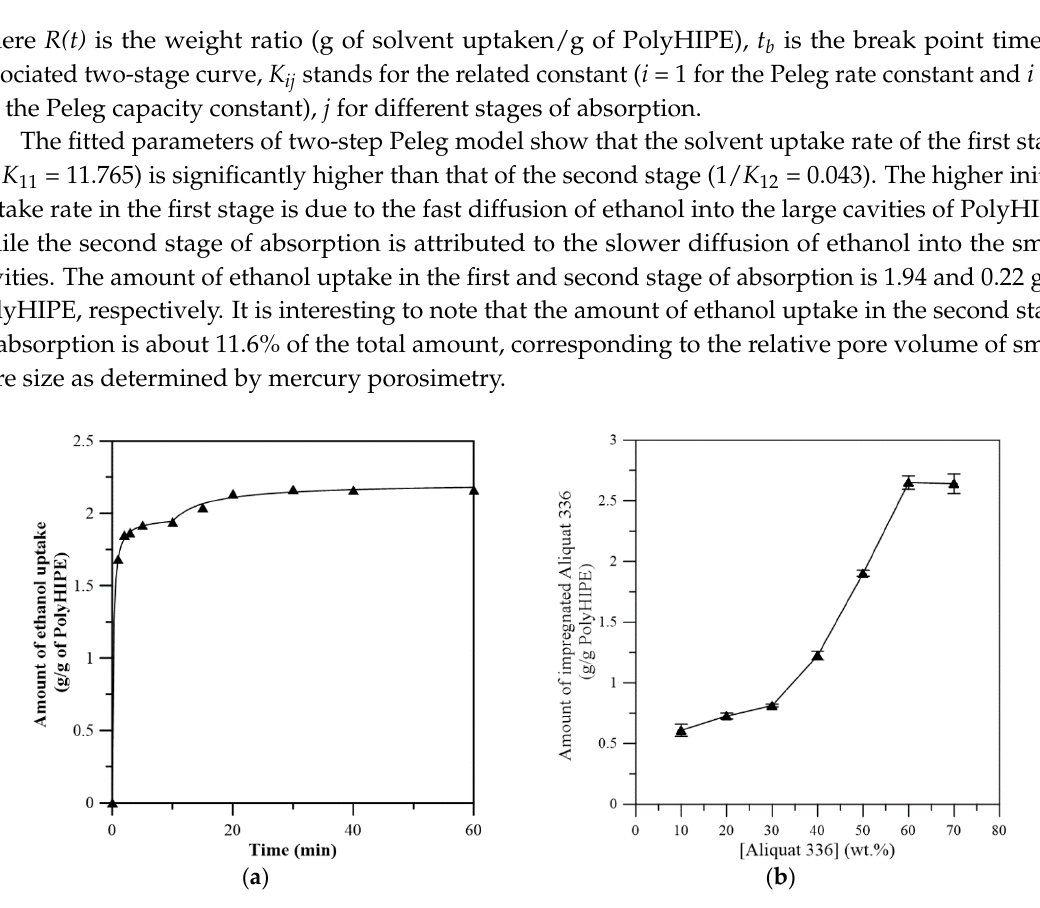
Figure 4. ( a ) Absorption of ethanol by PolyHIPE. ( b ) Effect of Aliquat 336 concentration in ethanol on the mount of immobilized Aliquat 336.